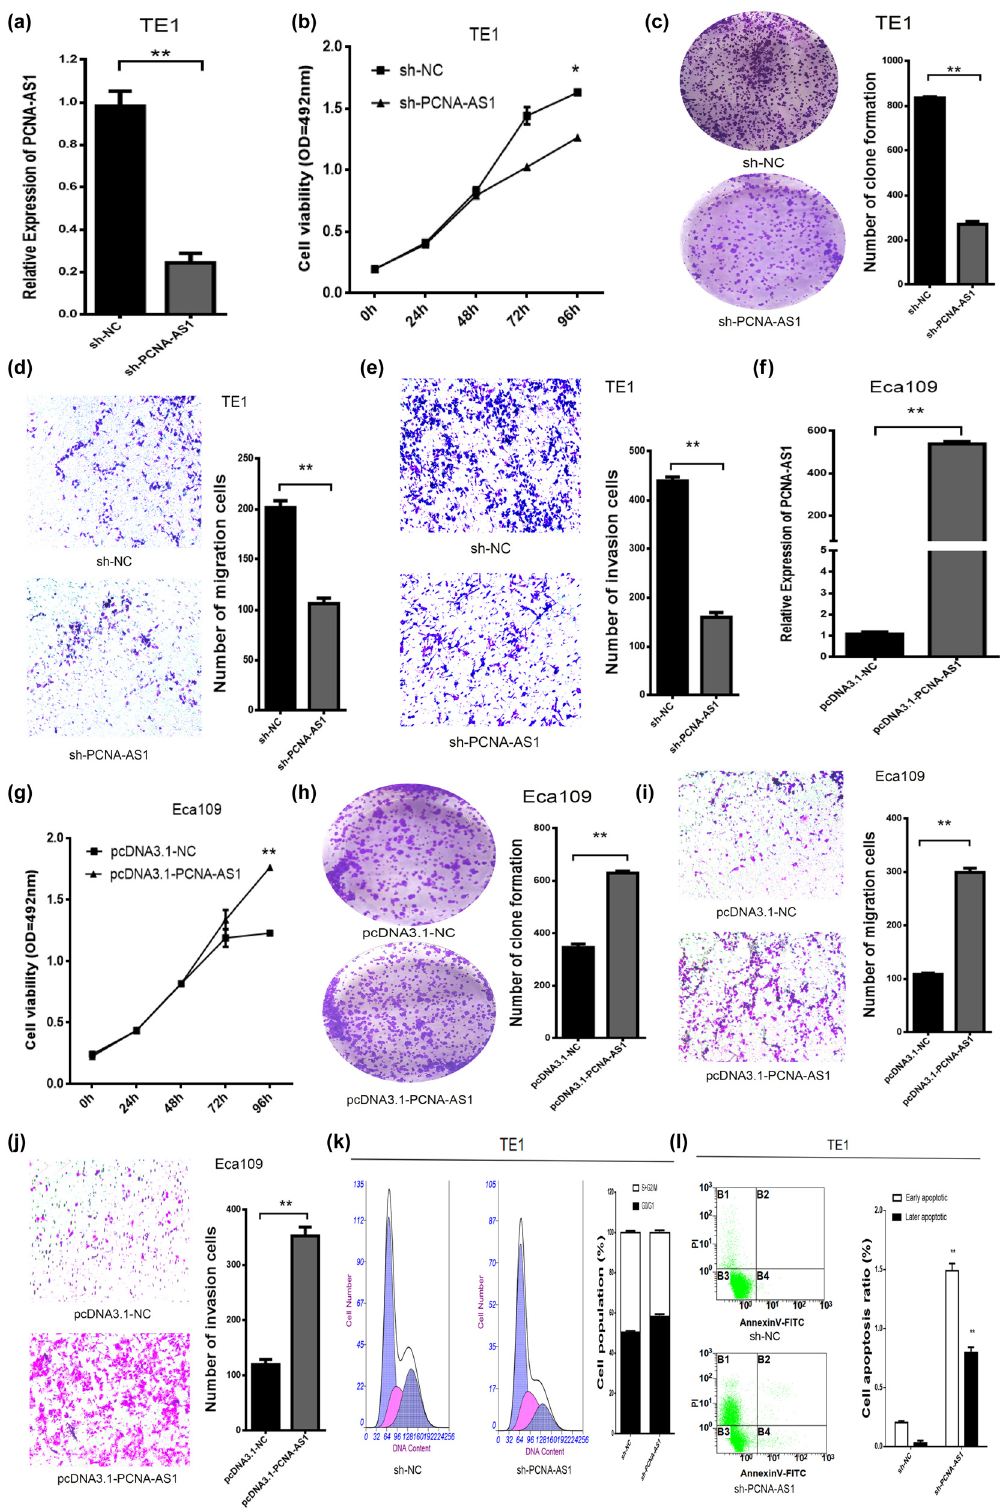
Figure 2: The e ff ect of PCNA - AS1 on the biological behavior of ESCC cells. ( a – e ) Knockdown of PCNA - AS1 on cell proliferation, migration, clone information and invasion. ( f – j ) Overexpression of PCNA - AS1 on cell proliferation, migration, clone information and invasion. ( k and l ) Knockdown of PCNA - AS1 on cell cycle and apoptosis. *P < 0.05 and **P <